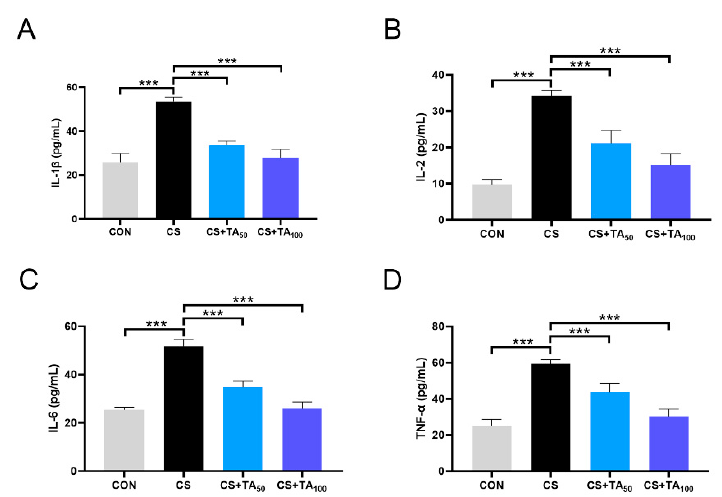
Figure 4. TA protects against inflammatory responses in CS-exposed COPD mice. Levels of ( A ) interleukin 1 β (IL-1 β ), ( B ) IL-2, ( C ) IL-6 , and ( D ) tumor necrosis factor alphs (TNF- α ) in the serum were measured. *** P < 0.001.